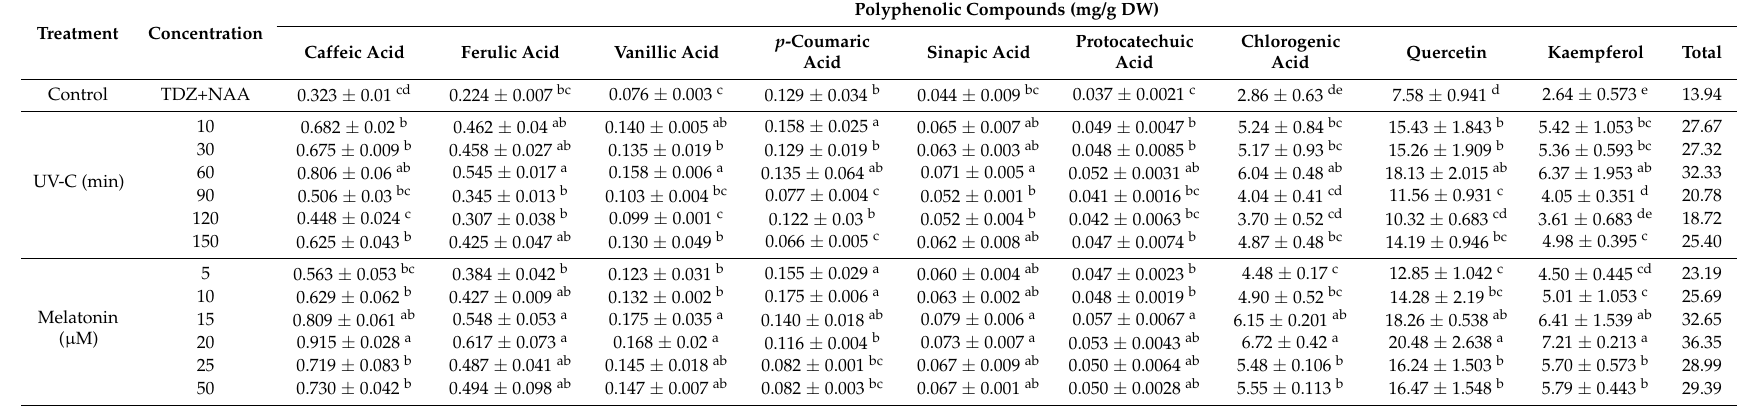
Table 2. Effect of UV-C and Melatonin on accumulation of phenylpropanoids in callus cultures of L. sativum . Columns with similar alphabets (letters a–e) are not significantly different ( p <